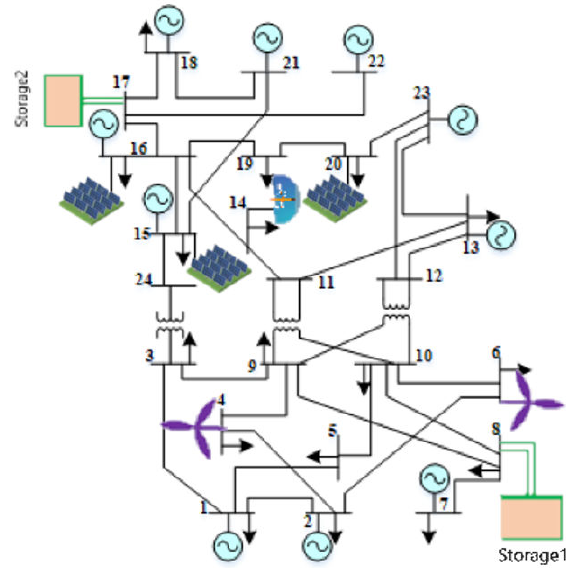
Figure 6. Single line schematic of IEEE 24-bus grid. Table 2. The bus and demand